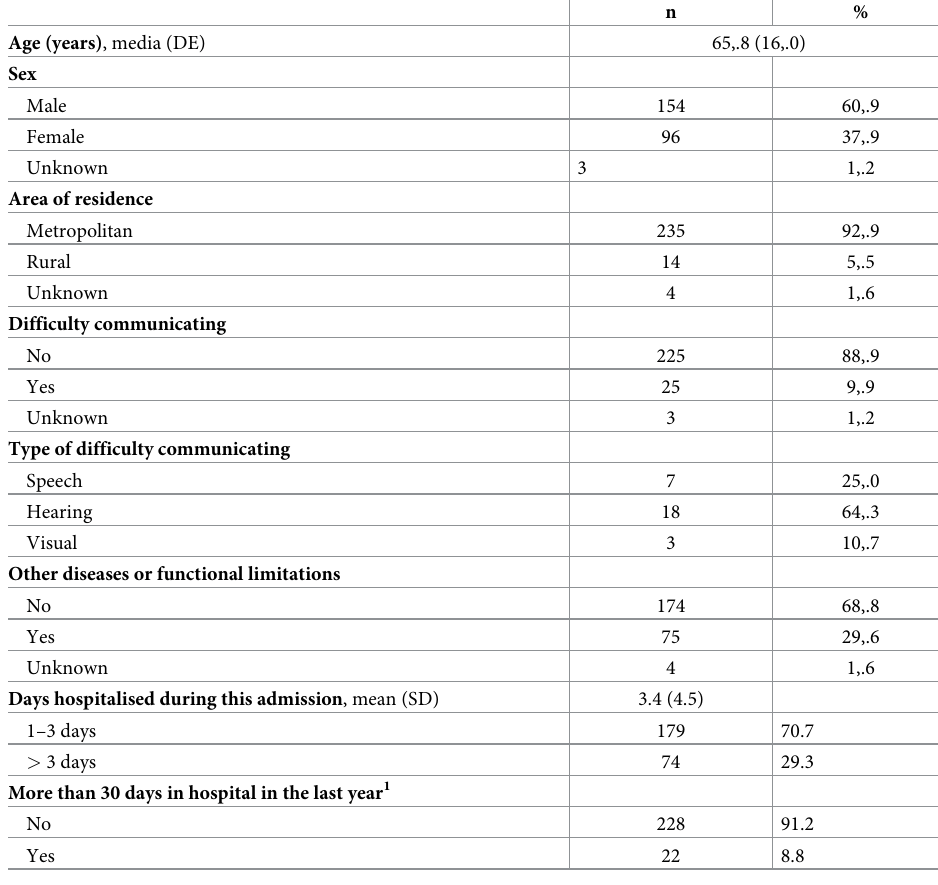
Table 1. Characteristics of patients admitted to the ICU (n = 253).